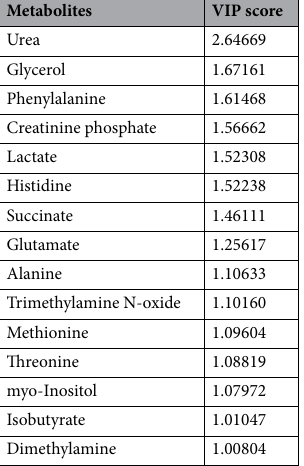
Table 2. VIP score of metabolites differentially expressed between the 1st HF and MCO dialyzer samples. VIP, variable important in projection; MCO, medium cut-off; HF, high